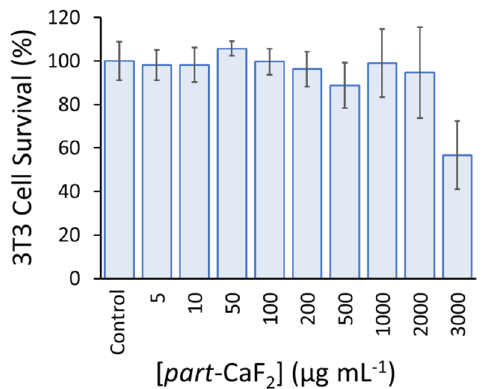
Figure 5. Cell viability of 3T3 fibroblast cell line incubated for 24 h with different concentrations of part -CaF 2 . The experiments were performed in 6